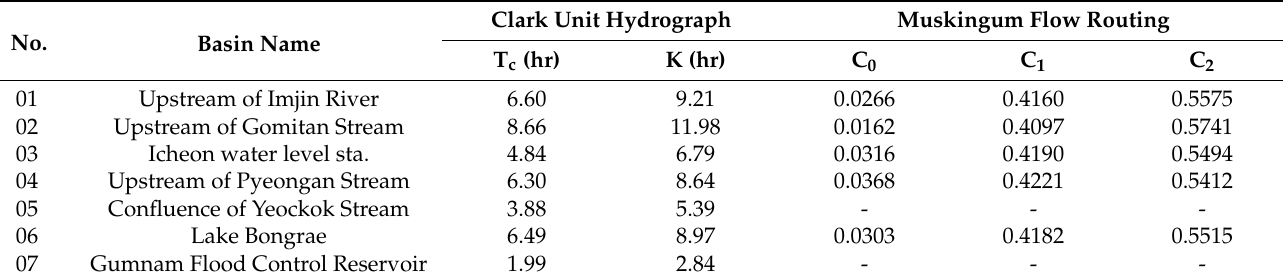
Table 4. The parameters of the Clark unit hydrograph and Muskingum flow